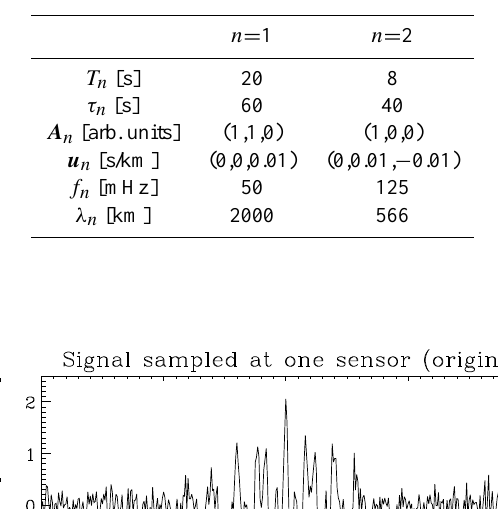
Table 1. Wave parameter values for the synthetic signal consisting of two planes waves in an isotropic noise background, see Eq. (36). Model parameters are the wave periods T n , the slowness vectors u n , the amplitude vectors A n , and the widths τ n of the Gaussian enve- lope function. The wave frequencies f n = 1 /T n and the wavelengths λ n = T n / | u n | are added for convenience.